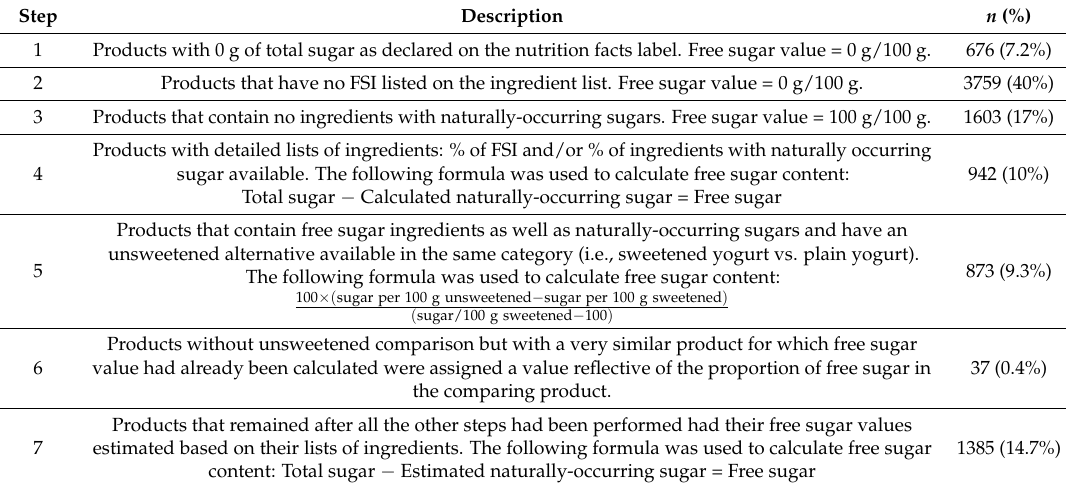
Table 1. The following step-by-step method was used to estimate the free sugar content of packaged foods. The method was adapted from Bernstein and colleagues [38]. n (%) indicates the number and proportion of products calculated at each